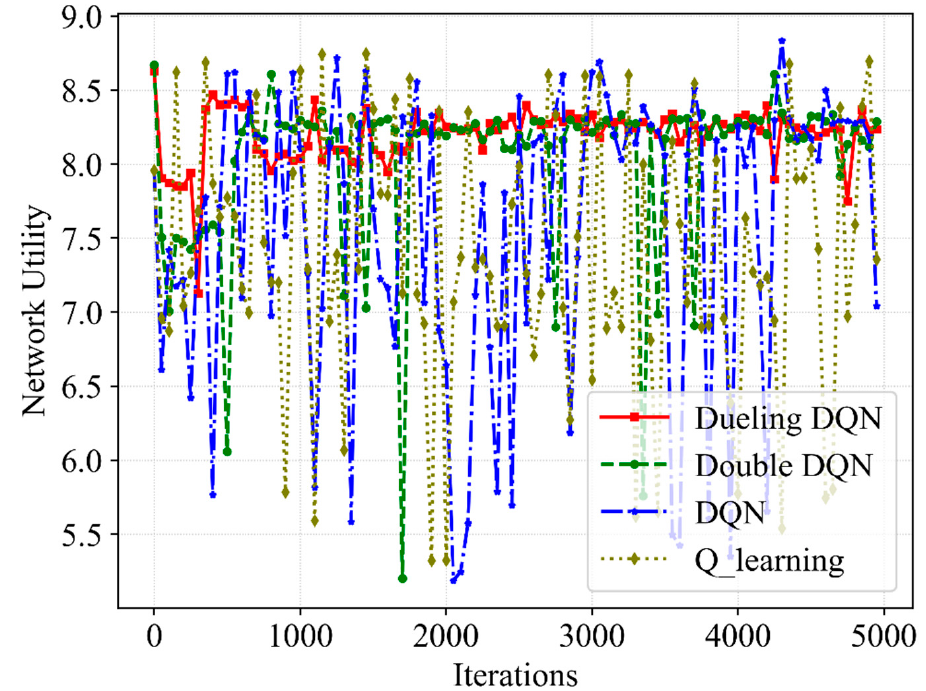
Figure 5. A comparative result of SE with different slicing algorithms.